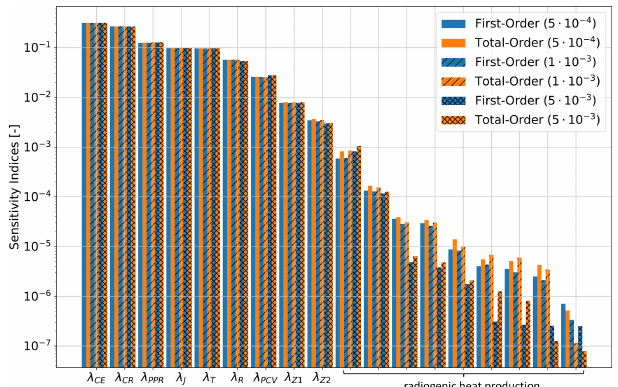
Figure 5. Global sensitivity indices for the analysis focused on the sedimentary layers of the Central European Basin System for an accuracy of the reduced model of 5 × 10 − 4 (solid lines), 1 × 10 − 3 (dashed lines) and 5 × 10 − 3 (dotted lines). The first-order indices are denoted in blue and the total-order indices in orange. For the acronyms, please refer to Table